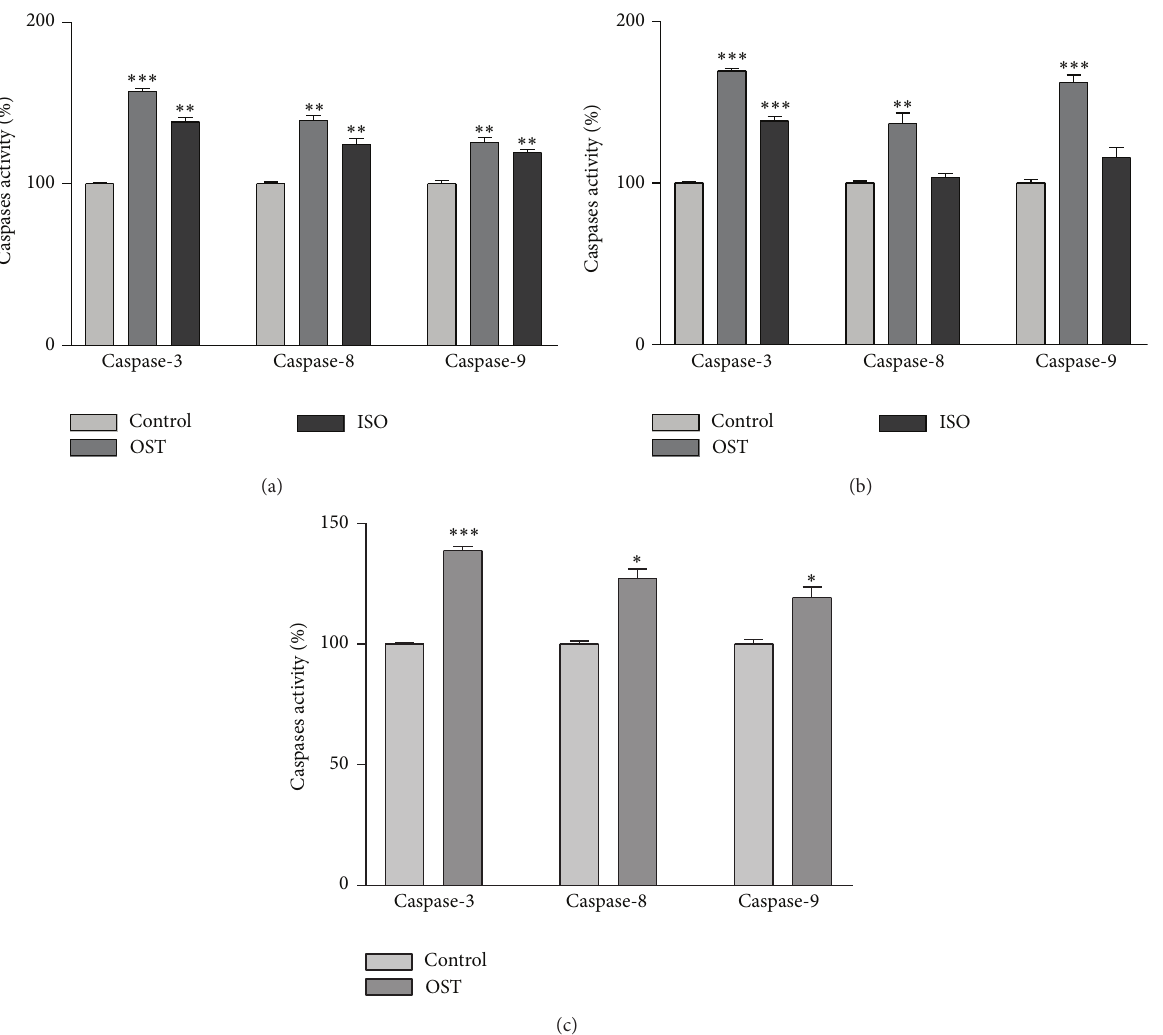
Figure 3: Involvement of activation of caspases in the induction of apoptosis on (a) SKNMC, (b) PC3, and (c) H1299 human cancer cells. Cells wereincubatedwithIC 50 concentrationoftheindicatedcompoundsandharvestedat24 handcelllysateswereassayedusingmicroplatereader for activation caspases. Significant differences were compared with the control. Data are presented as mean ± S.E.M. ∗ 𝑃 < 0.05 , ∗∗ 𝑃 < 0.01 , and ∗∗∗ 𝑃 < 0.001 versus